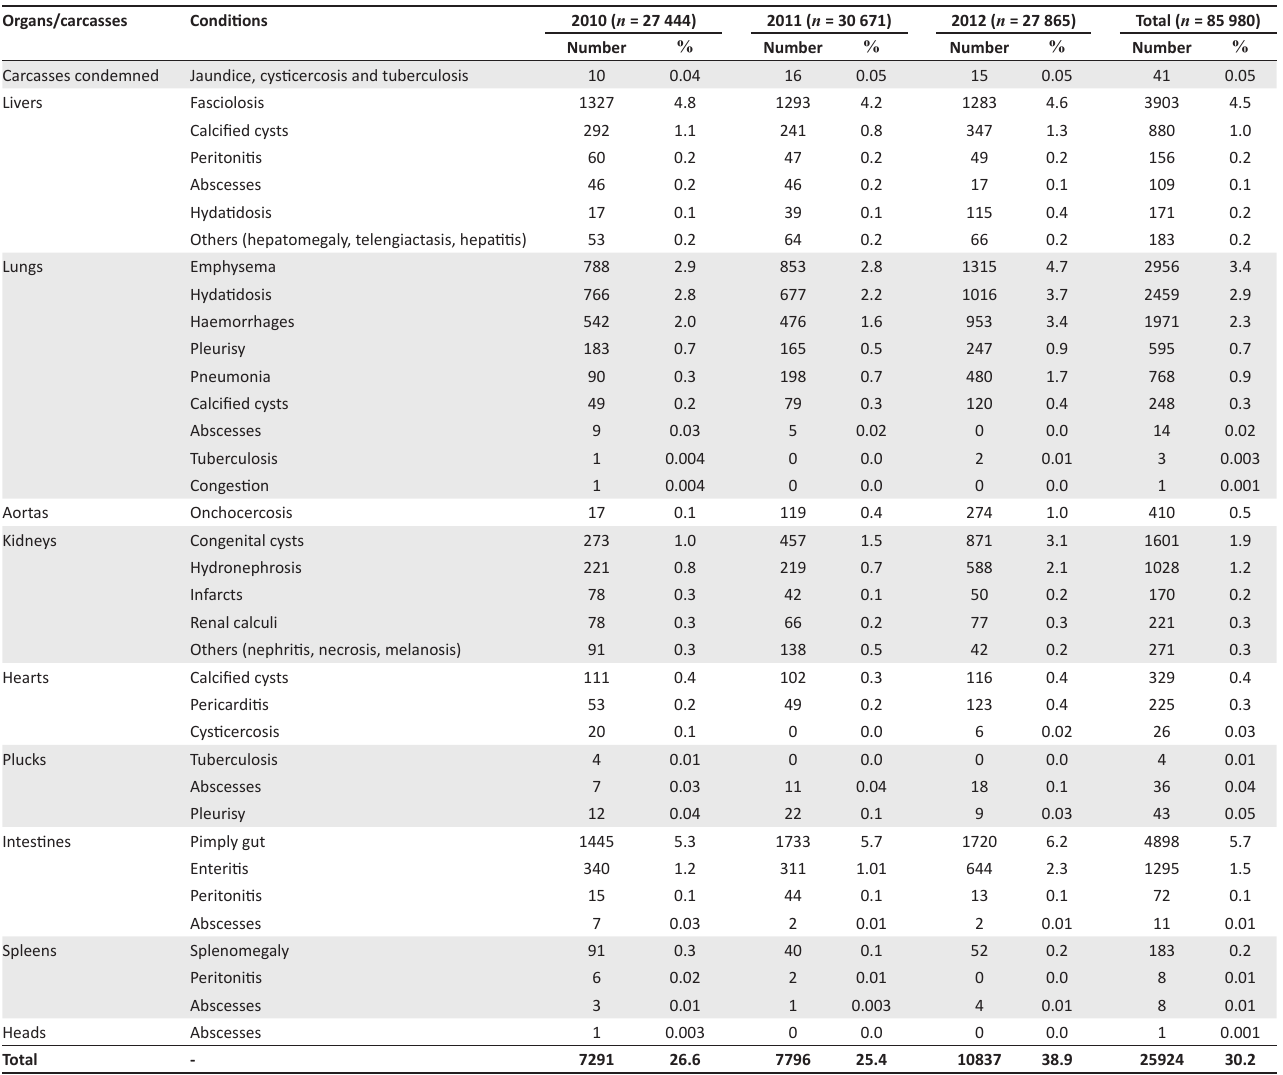
TABLE 1: Number and percentage of organs and/or carcasses condemned according to condition at Dodoma abattoir, Tanzania for the period 2010–2012.